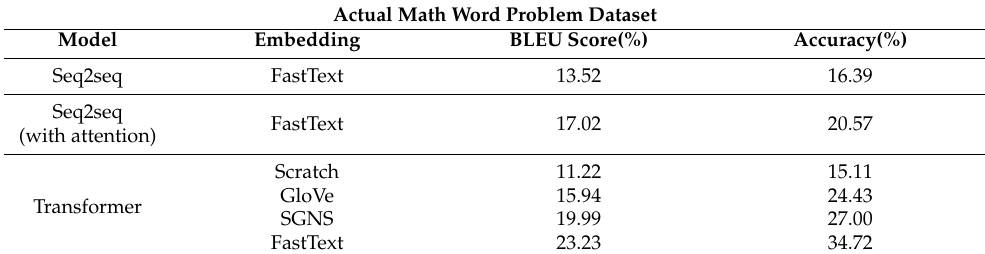
Table 9. Outcomes of the model when applied to real-world data.